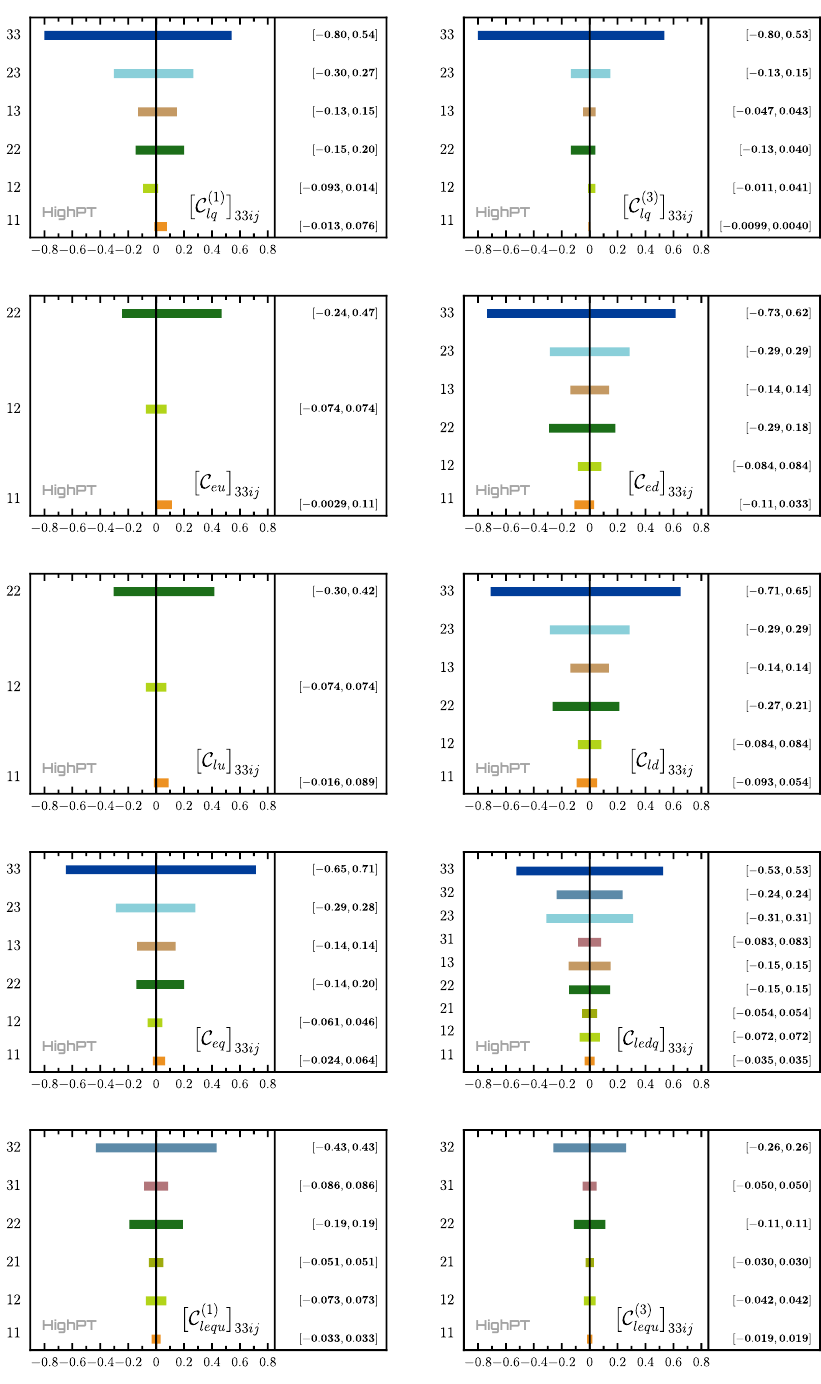
Figure 14. LHC constraints on semileptonic d = 6 Wilson coefficients with ττ flavor indices to 95% CL accuracy, where a single coefficient is turned on at a time. Quark-flavor indices are denoted by ij and are specified on the left hand-side of each plot. All coefficients are assumed to be real and contributions to the cross-section up to and including O (1 / Λ 4 ) are considered. The New Physics scale is chosen as Λ = 1 TeV